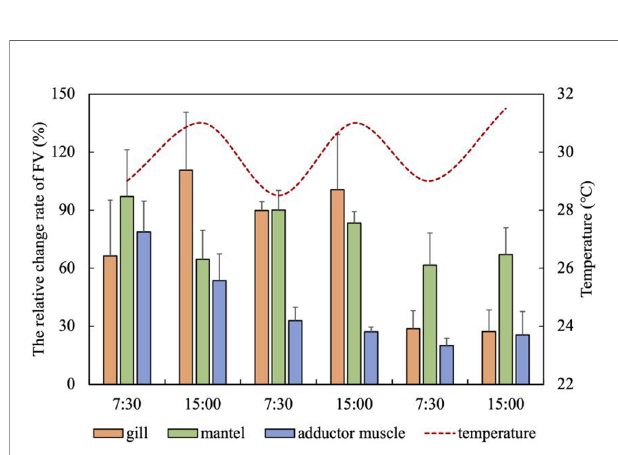
FIGURE 7 | Changes in scallop HR under high temperature fl uctuations ( ‘ normal ’ represent the scallop int the condition of 26°C and 6.5 mg/L DO) (mean ± SE,